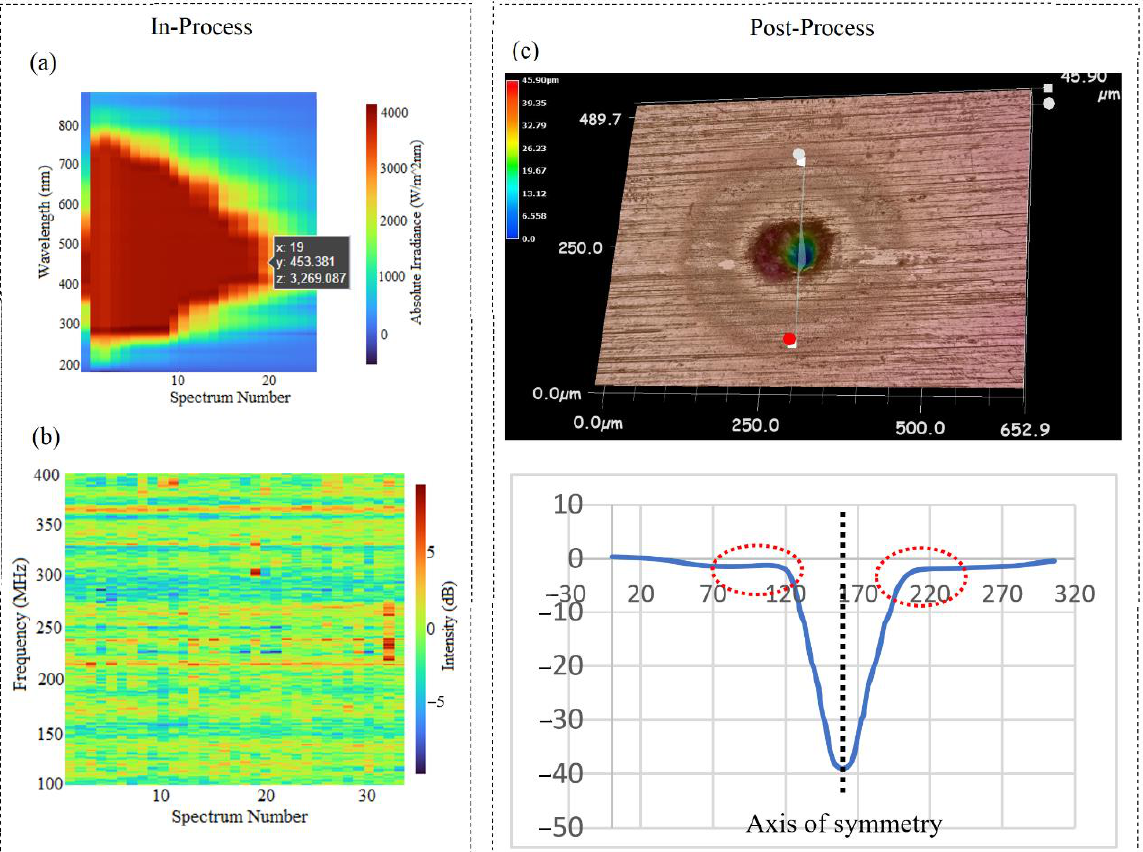
Figure 3. In-process visualization of ( a ) OES Heat Map and ( b ) RES Heat Map and ( c ) post-process microscopic images. For the OES heat maps and RES heat maps 25 and 34 spectra were taken across 2 s of ablation time, so each “spectrum number” corresponds to a period time of approximately 80 ms and 59 ms, respectively.